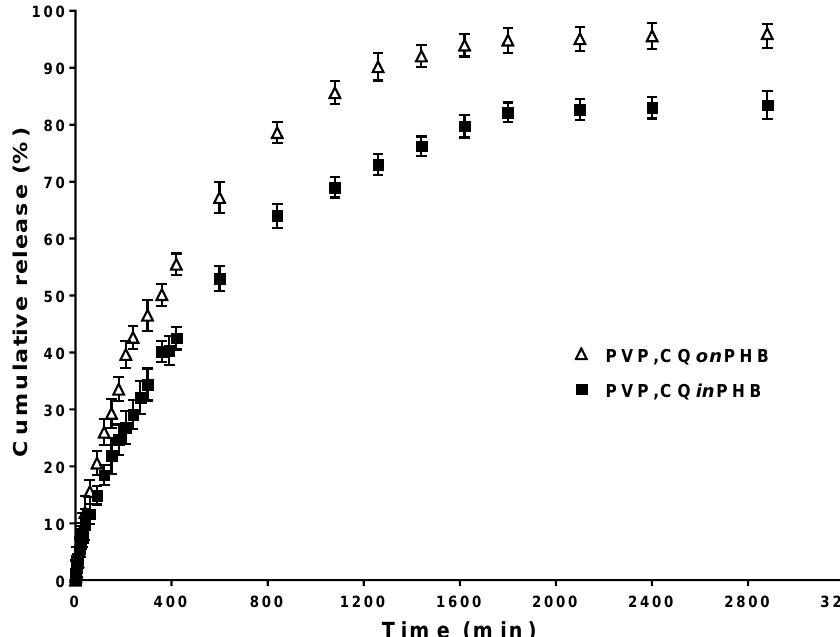
Figure 8. In vitro study of the CQ release from: PVP,CQ in PHB and PVP,CQ on PHB mats in acetate buffer/Tween 80 (99/1 v / v ) at 25 ◦ C, pH 3.6, ionic strength buffer/Tween 80 (99/1 v / v ) at 25 °C, pH 3.6, ionic strength 0.1.